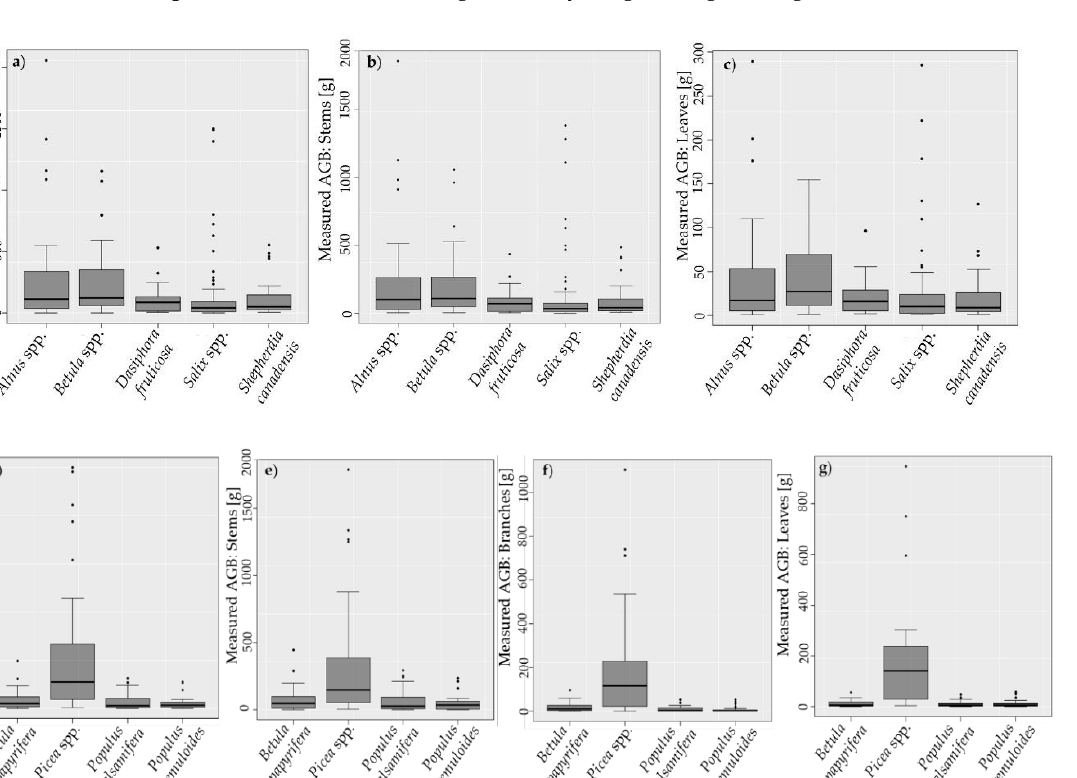
Figure 2. Measured aboveground biomass [%] per plant component for common boreal ( a ) shrub and ( b ) short-stature tree genera/species.